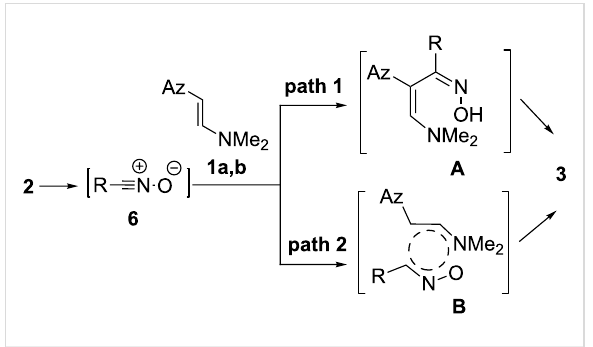
Scheme 3: Plausible mechanisms for reaction of hydroxamoyl chlo- rides 2 with imidazolyl enamines 1a,b .